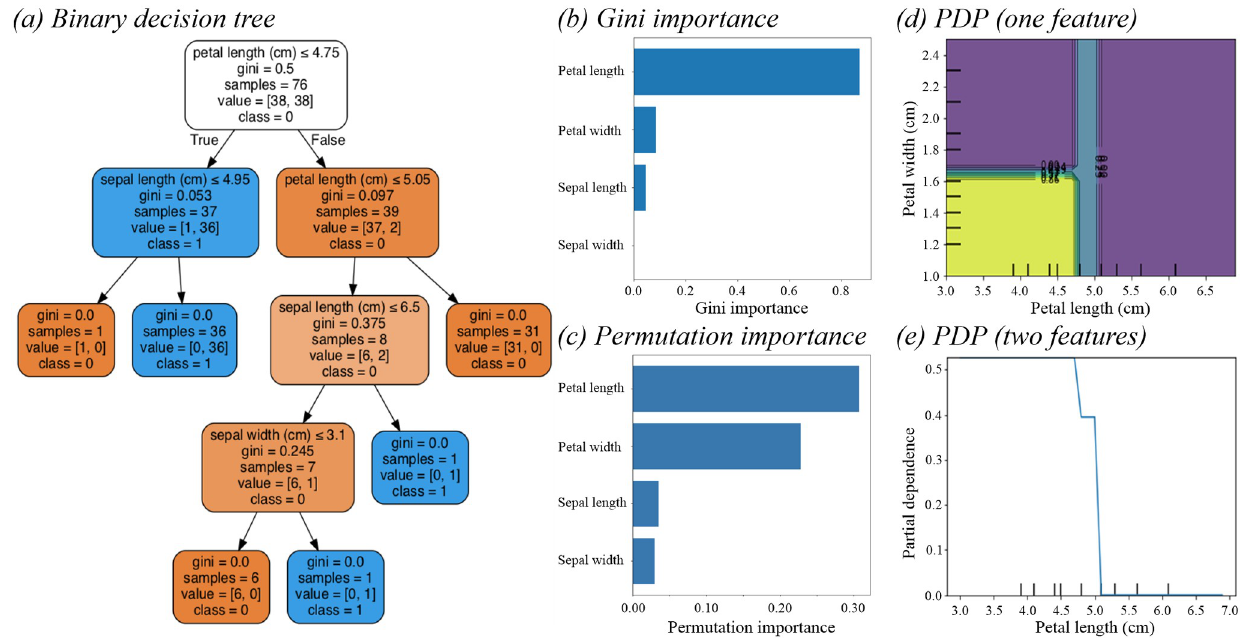
Fig 1. Single binarized decision tree created in SKlearn to classify the Iris dataset. (a) A single binarized decision tree was created in the sklearn DecisionTreeClassifier package to effectively delineate the Iris dataset. The depth four tree used Iris versicolor as the negative class (= 0), and Iris Virginica as the positive class (= 1). Iris Setosa was removed from the classification system to allow the binarization of the dataset. (b) We calculated the Gini Importance for our decision tree using sklearn’s “feature_importances_” property. This revealed ‘petal length’ to be the most important feature in the model for classification into the positive or negative class. (c) When performing permutation importance on our four features included in our simple decision tree, we found that permuting the values of petal width had the greatest impact on the model prediction error when attempting to classify data to the positive or negative class. Unlike Gini importance, this analysis revealed that petal length was also significantly important in the classification process, whilst sepal length and width again were found to be relatively unimportant in the decision making process, and permutation of these features did not greatly impact model prediction error. (d) A one feature partial dependence plot (PDP) for ‘petal length’ revealed that positive classification as Iris Virginica (partial dependence) was non-linearly related to ‘petal length’, with a critical point at 5cm marking certain negative (Iris Versicolor) classification. (e) By introducing ‘petal width’ and conducting a two feature PDP, we were able to determine that these two features were increasingly dependent for positive classification at values lower than 5cm and 1.6cm for petal length and width respectively, giving us directional and magnitudinal inferences between two features (For two feature PDP’s, a colour map is added to help visualise dependencies such that green indicates a greater partial dependency than